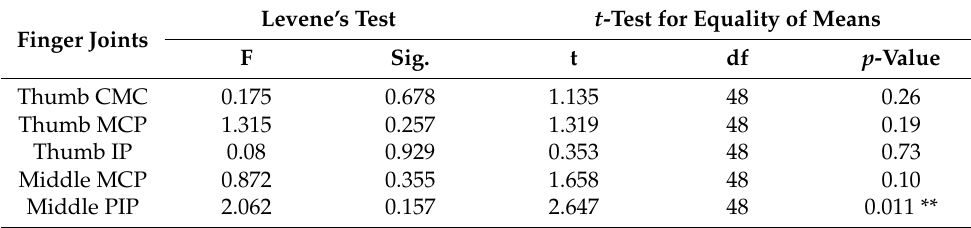
Table 5. Independent samples t -test for comparison flexion angles with respect to Test 13 and Test